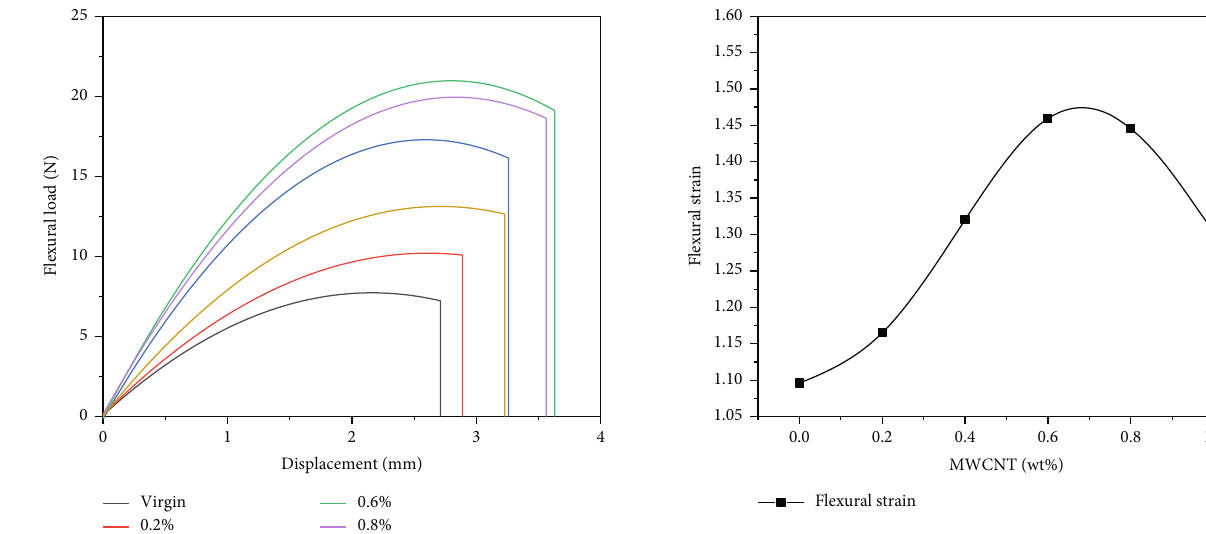
Figure 4: Flexural strain of MWCNT nanocomposites.